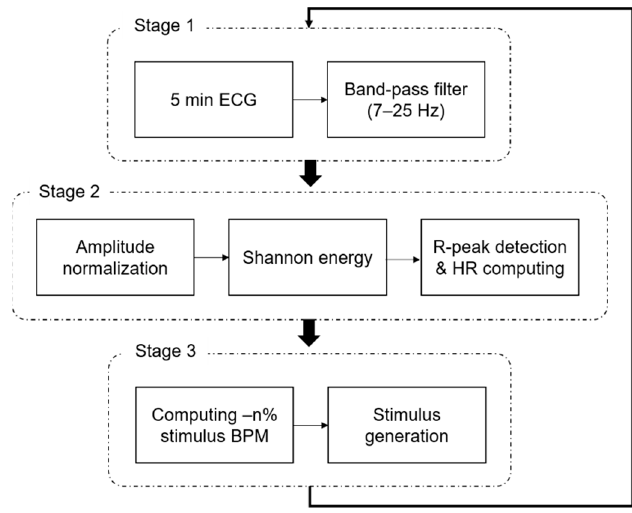
Figure 2. Block diagram of the closed-loop processes. BPM—beats per minute.